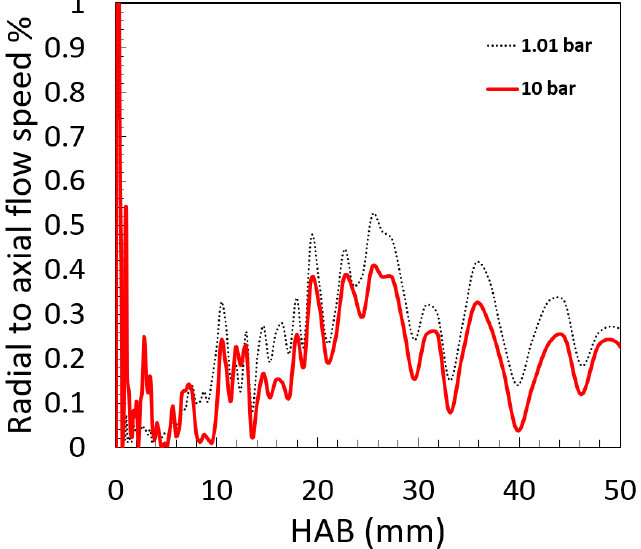
Figure 5. Cross-sectional distribution of radial flow velocity (m/s) along window and inter-window axes of burner of premixed flame C 2 H 4 /air φ = 1.77 at atmospheric pressure ( a ) and 10 bar ( b ).